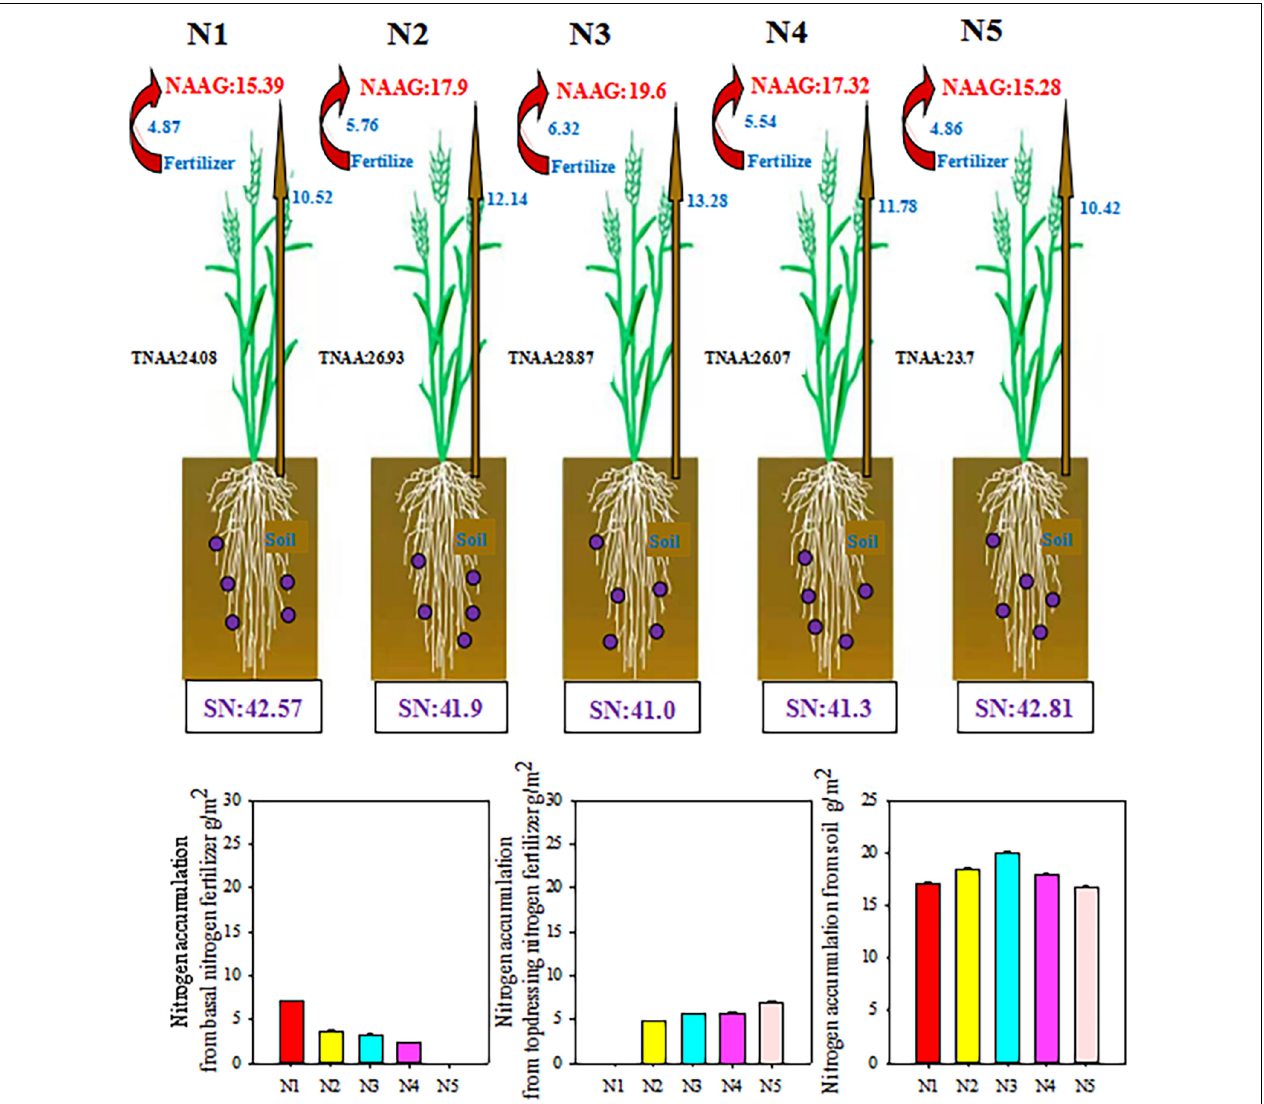
FIGURE 5 | Effect of split nitrogen fertilizer on the plant nitrogen accumulation form fertilizer or soil. NAAG, nitrogen accumulation amount in grains; TNAA, Total plant nitrogen accumulation amount; SN, soil inorganic nitrogen content. N1 (basal/dressing, 100/0%), N2 (basal/dressing, 70/30%), N3 (basal/dressing, 50/50%), N4 (basal/dressing, 30/70%), and N5 (basal/dressing,